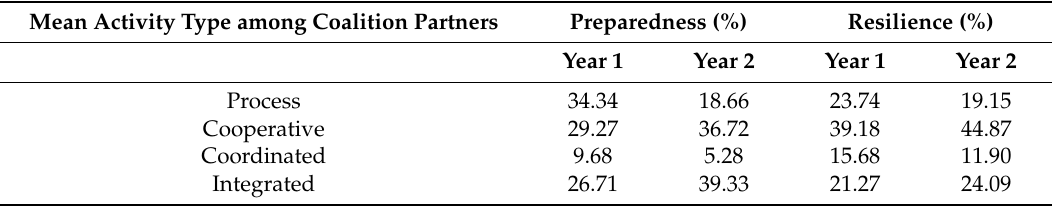
Table 3. Activity Types by Community Type and